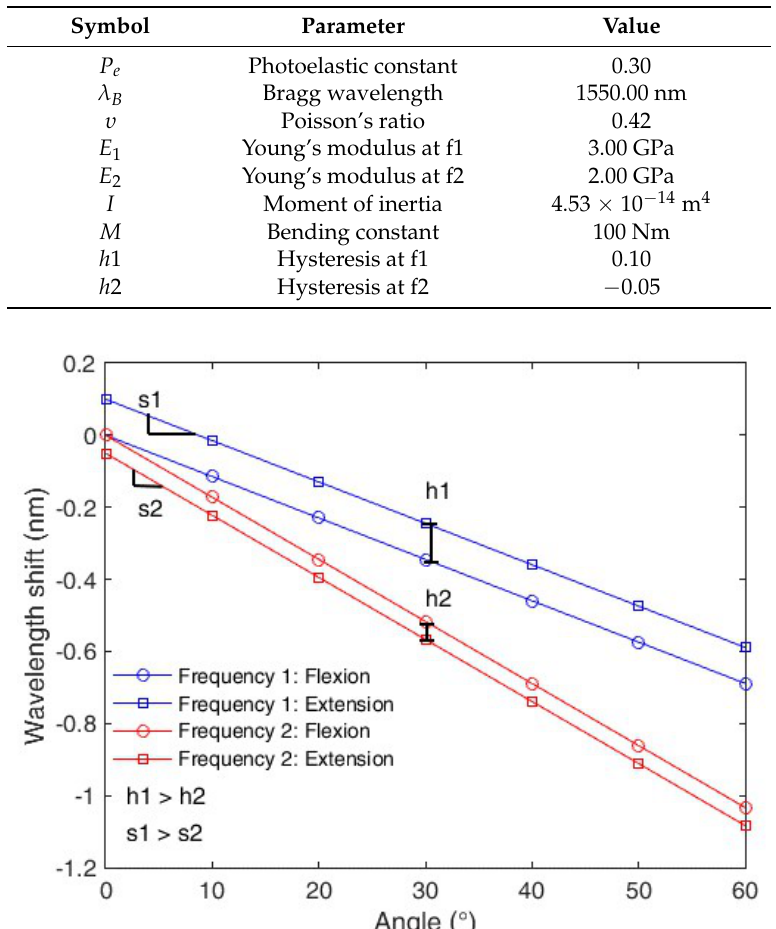
Figure 1. Schematic illustration of the frequency effect on the sensor sensitivity and linearity for two different frequencies; where h 1 and h 2 are the hysteresis for the frequencies 1 and 2, respectively. Analogously, s 1 and s 2 are the sensitivities for frequencies 1 and 2, respectively.